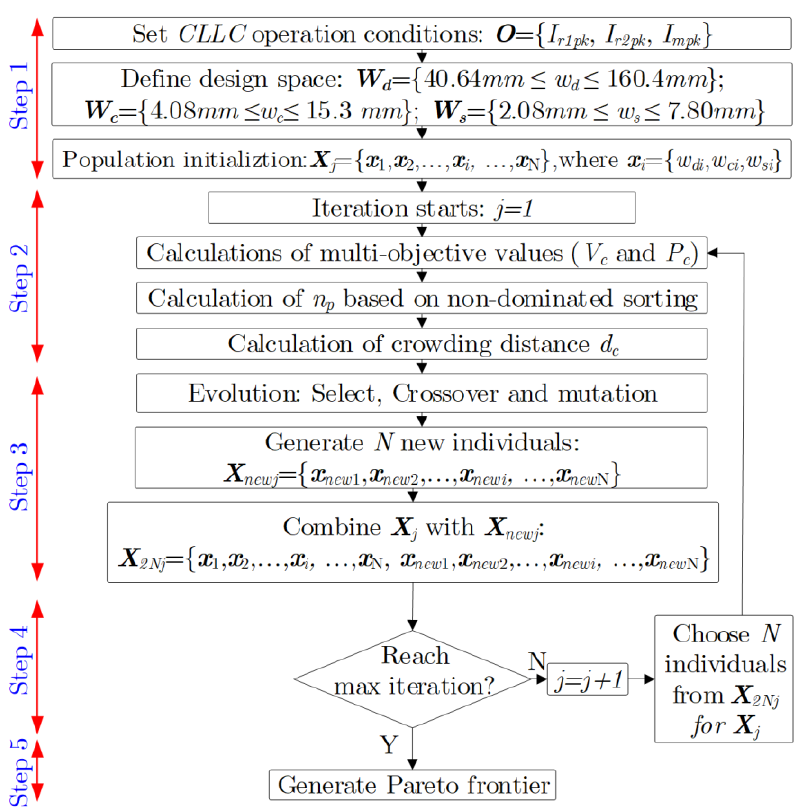
Figure 11. Flowchart of the Pareto optimization procedure of the proposed integrated magnetic structure.